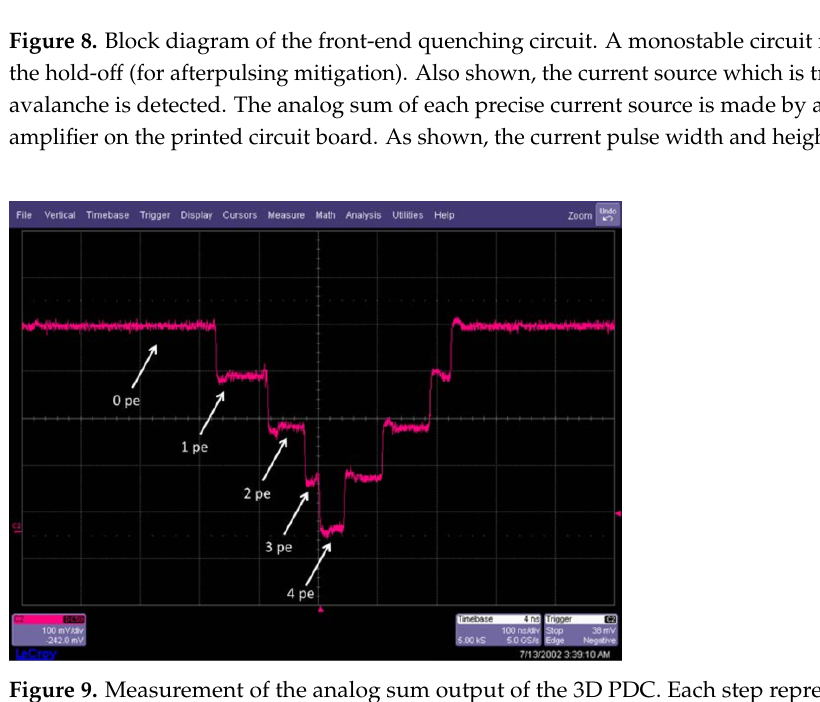
Figure 9. Measurement of the analog sum output of the 3D PDC. Each step represents a triggered SPAD. The current pulse width and height can be